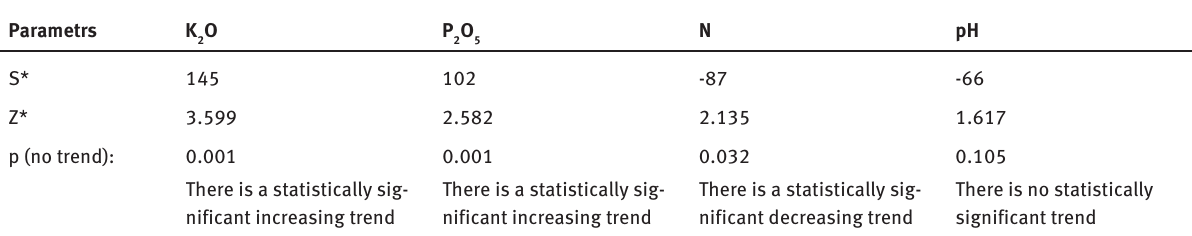
Table 4: Mann-Kendall trend test for agrochemical properties of study soils